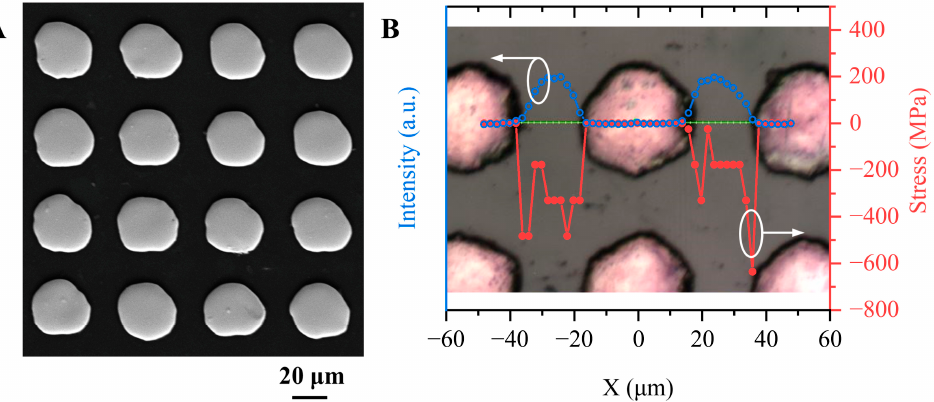
Figure 6. ( A ) SEM morphology of the TDV surface after complete electroplating. ( B ) Stress distribu- tion of the diamond around the Cu ‐ filled TDV front surfaces according to the Raman measurement.